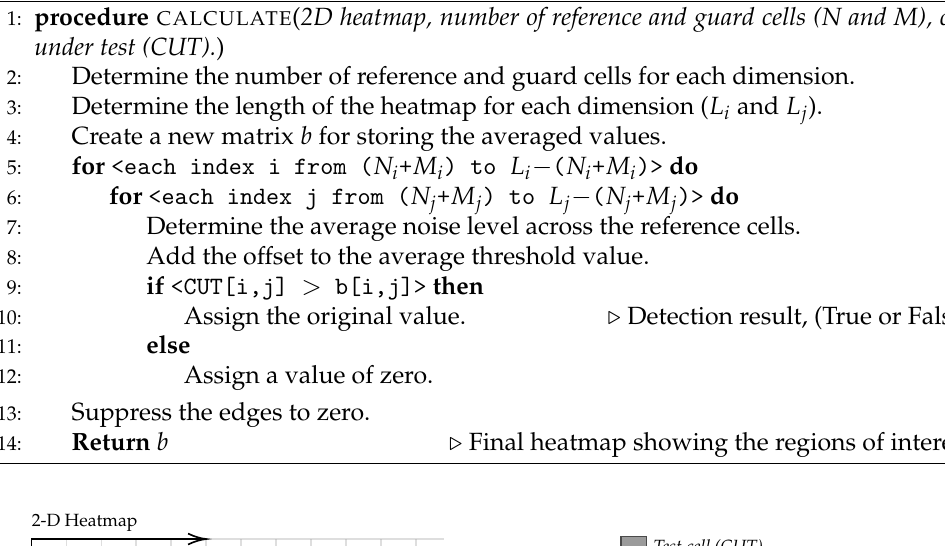
Algorithm 1 Disease Extent Detection from CNN Heatmaps